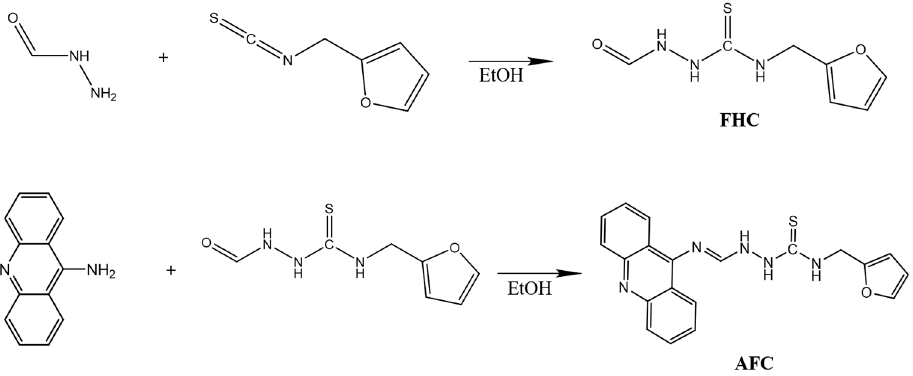
Scheme 1. Synthesis of AFC .